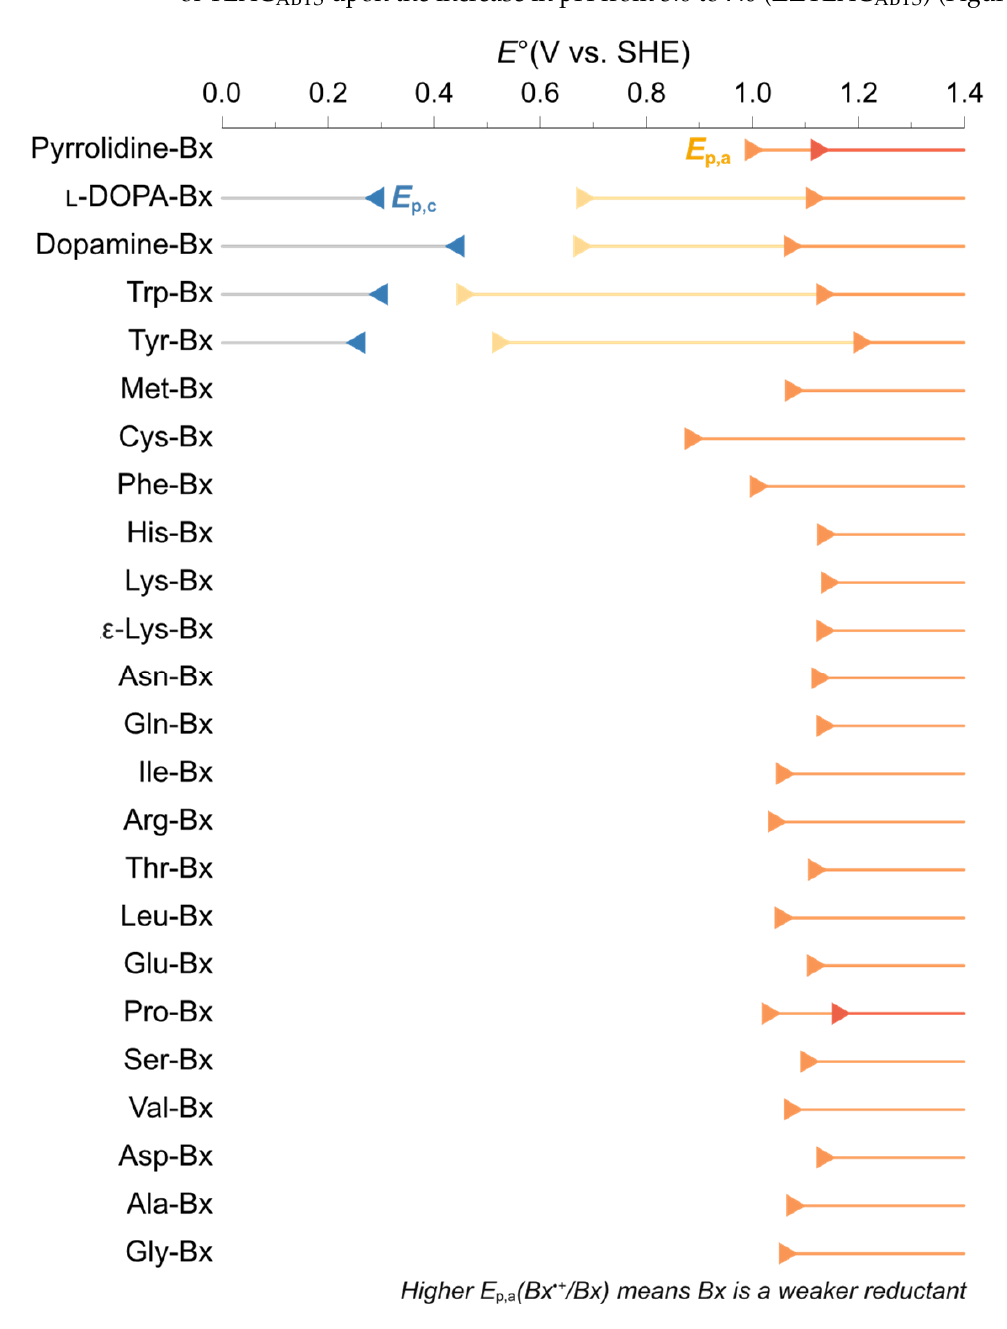
Figure 5. Peak potentials of betaxanthins derived from L-amino acids, dopamine, and pyrrolidine determined by cyclic voltammetry. Cathodic ( ◄ ) and anodic ( ► ) potentials were determined using screen printed vitreous carbon electrodes against an Ag/AgCl reference electrode and a carbon auxiliary electrode; potential range: −0.4 to 1.0 V, scan rate: 50 mV s −1 , betaxanthin concentration: 1 mmol L −1 in aqueous KCl (0.1 mol L −1 ) at pH 7.0.